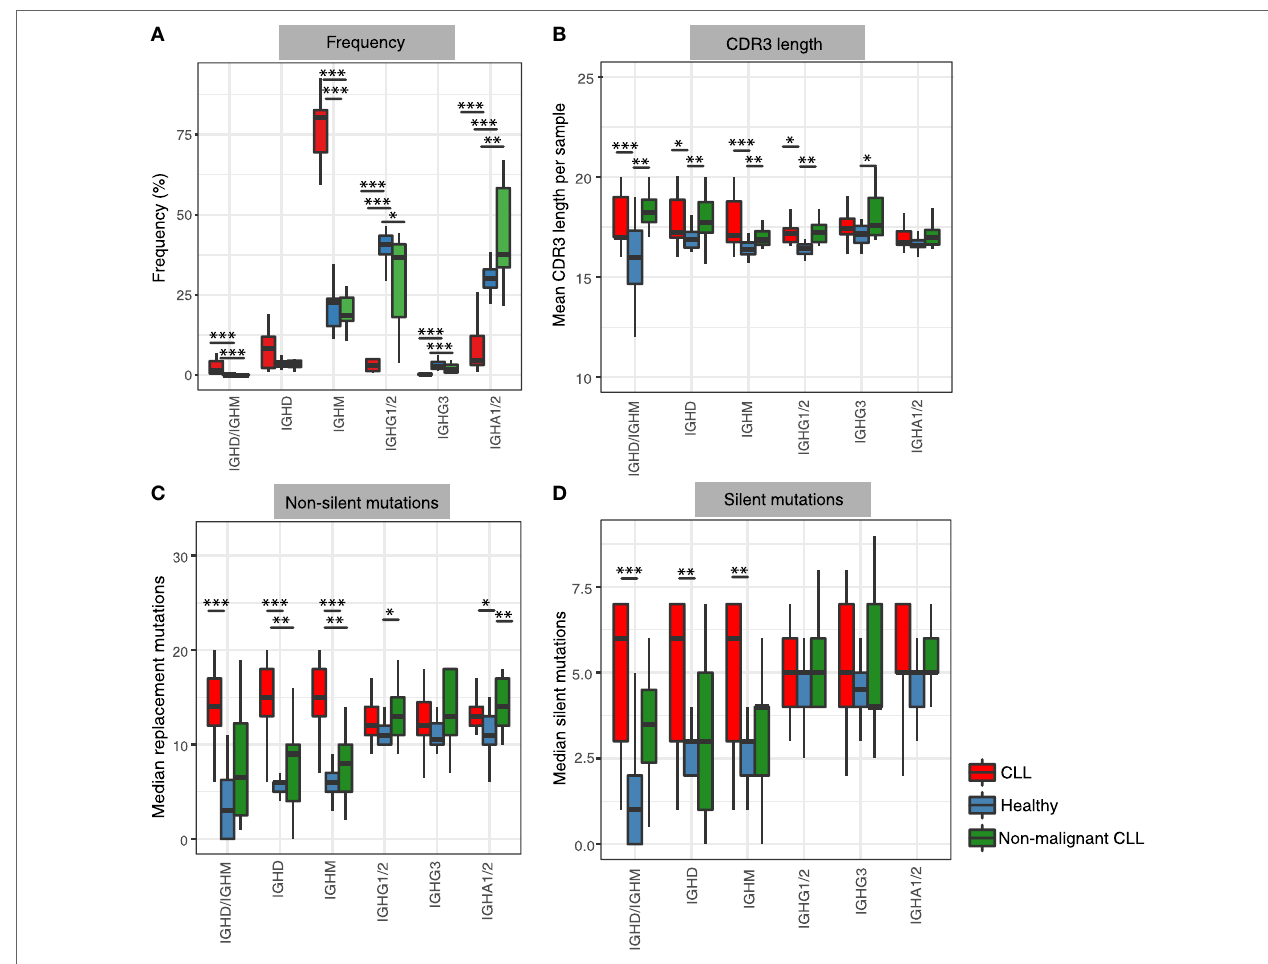
FigUre 1 | Frequency and mutational status of antibody isotypes in healthy and in leukemic repertoires. (a) Frequency of unique B-cell receptor (BCR) corresponding to each isotype across total CLL repertoires (red), healthy peripheral blood mononuclear cell repertoires (blue), and non-malignant CLL repertoires (excluding the major malignant clones) (green). Frequency of each isotype (sub)class is represented as a percentage of the unique BCRs corresponding to a specific isotype per individual. (B) Differences in complementarity determining region 3 (CDR3) amino acid lengths of unique BCRs corresponding to each isotype calculated as mean CDR3 length per isotype per sample. (c) Differences in non-silent mutations in IGHV genes of unique BCRs calculated as median non-silent mutation per isotype per sample. (D) Differences in silent mutations in IGHV genes of unique BCRs calculated as median silent mutation per isotype per sample. In all panels *** p -value < 0.0005; ** p -value < 0.005; and * p -value < 0.05 (Wilcoxon rank-sum test of the respective metric in each panel compared between healthy and disease